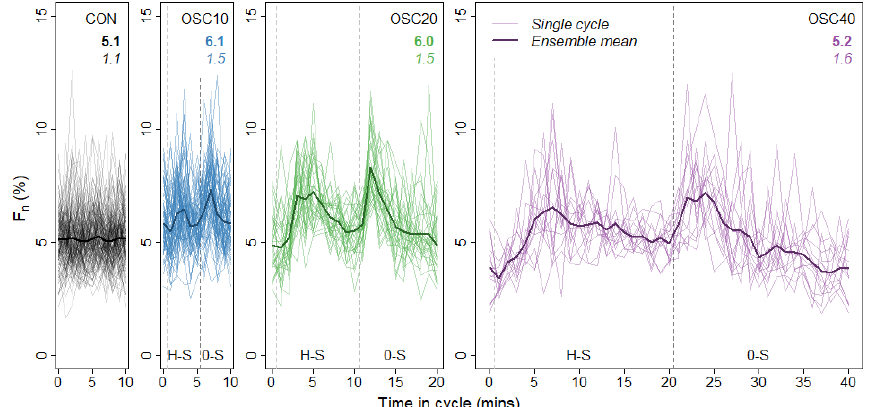
Figure 8. F n (across the whole fan) versus time in the sediment supply oscillation cycle. The thin lines represent each individual supply oscillation cycle; the thick line is the ensemble mean. H-S denotes the high-supply period; 0-S denotes zero sediment supply. Coloured text indicates each experiment’s time-averaged mean (in bold) and standard deviation (in